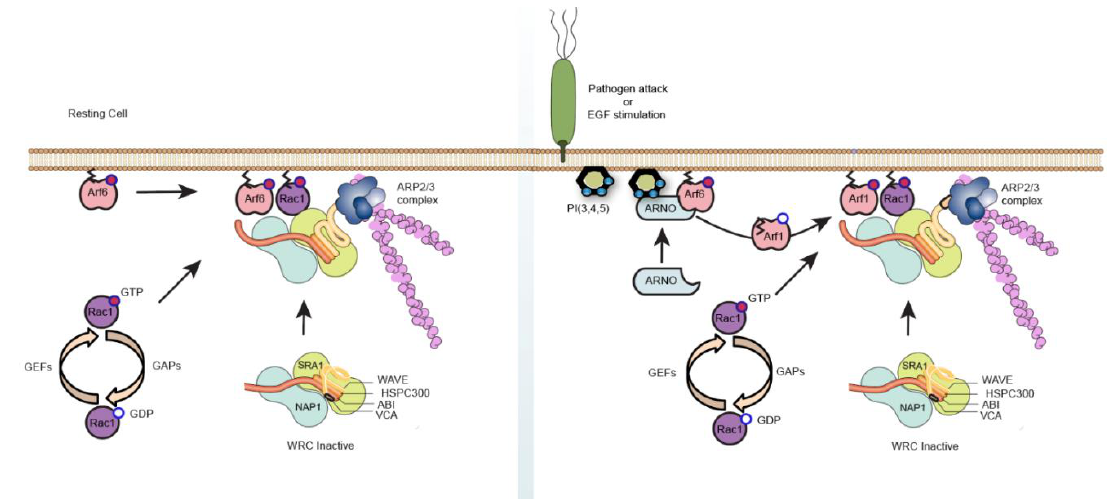
Figure 5. Schematic representation describing signaling to actin cytoskeleton by Arf6 GTPase. When the cell is in a resting state, Arf6 can mediate actin cytoskeleton rearrangement (via the wave regulatory complex) in co-operation with Rac1 to facilitate generic processes. This actin assembly is independent of ARNO and Arf1 interaction. On the contrary, when the cell is under an external stimulus, such as EGF, which results in acute PIP3 generation or during Salmonella entry, it switches to a more specific, stronger, short, and efficient means to bring about actin remodeling governed by ARNO/Arf1 recruitment, as described previously [12,13].